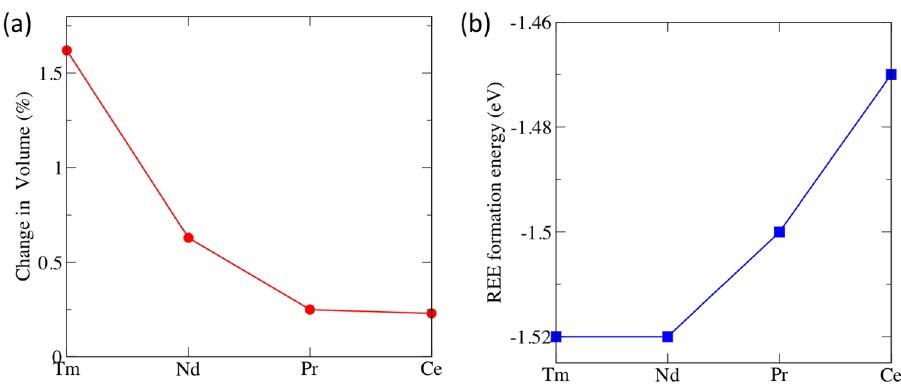
Figure 4. ( a ) Change in volume of BGO upon doping with REE ( b ) Formation energy of doped REE